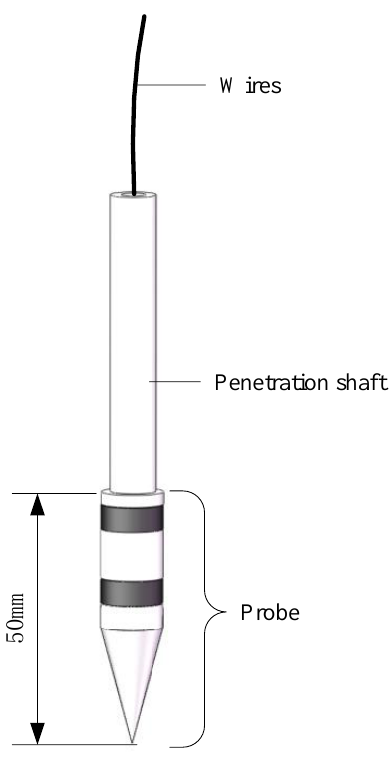
Figure 1. Diagram of the compound sensor.